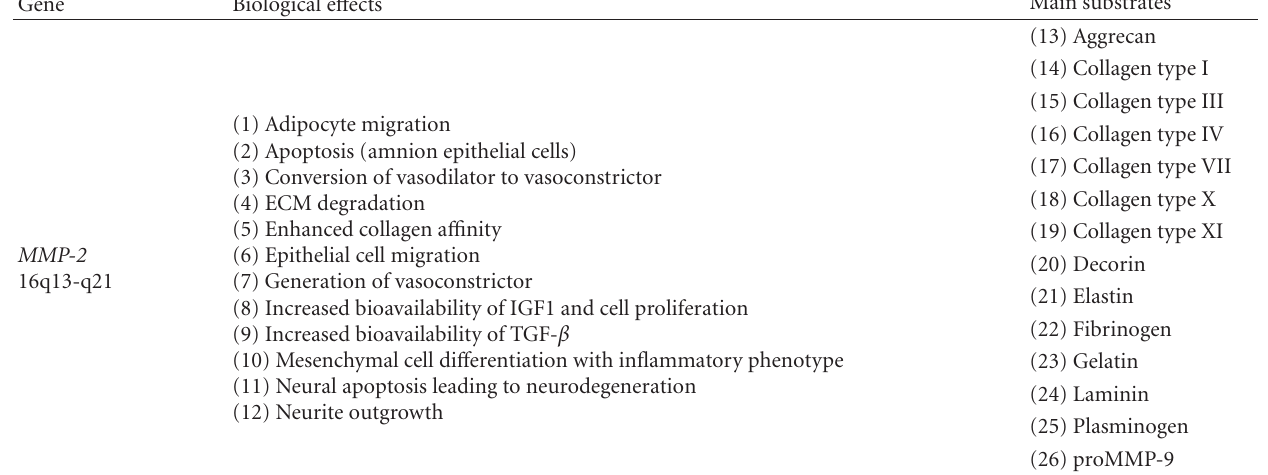
Table 1: Metalloproteinase-2 and metalloproteinase-9 chromosome location, biological e ff ects and substrates of action.